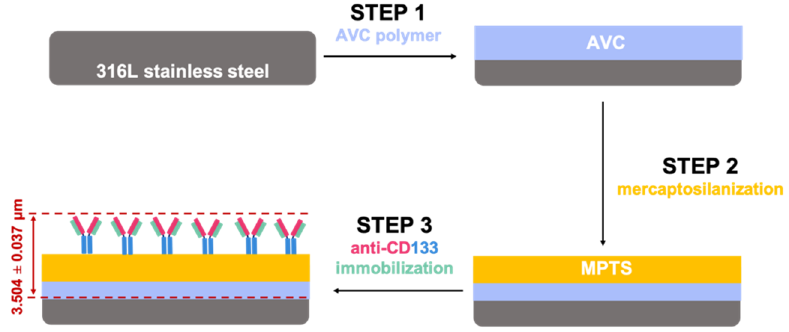
Figure 1. The general concept of the work—a schematic representation of the proposed method of antibody immobilization on the ammonium acryloyldimethyltaurate/vinylpyrrolidone co-polymer- based coating surface.